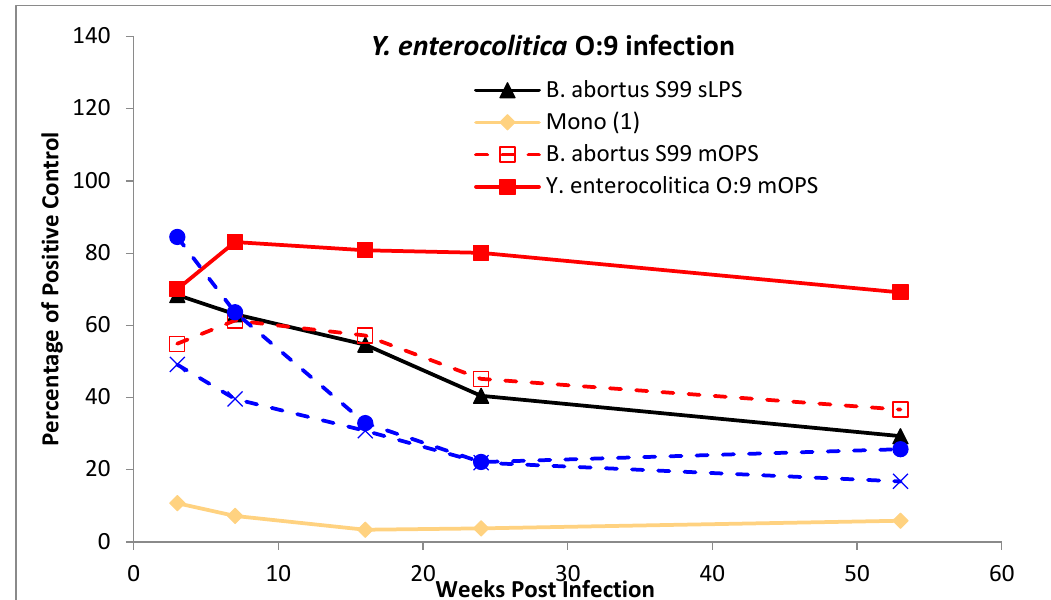
Figure 4. Average results from iELISA performed with sera collected from four cattle experimentally infected with Y. enterocolitica O:9 and at five sampling dates (3, 7, 16, 24 and 53 weeks post infection) as show on the x -axis. The sera were tested against B. abortus S99 sLPS (solid black line), B. abortus mOPS (dashed red line), Y. enterocolitica O:9 mOPS (solid red line), 2,2,2,2,2-Hexa (9) (dashed blue line), 2,2-Tri (5) (solid blue line) and Mono (1) (solid yellow line) antigens. The iELISA results ( y -axis) are expressed as a percentage of a common positive control that was applied to each antigen type.